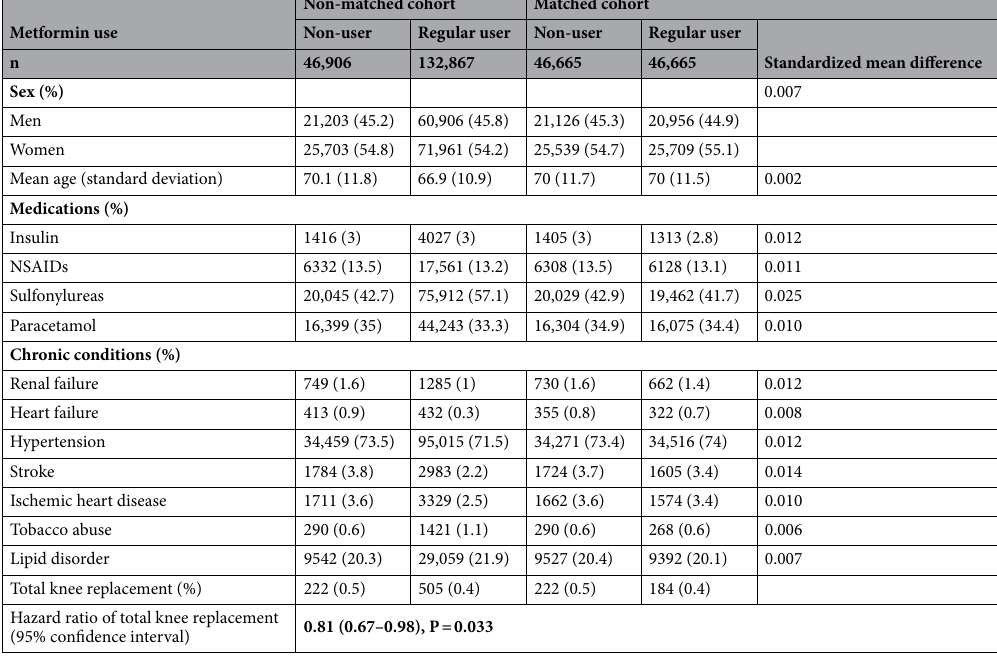
Table 1. Baseline characteristics of propensity score-matched cohort and non-matched